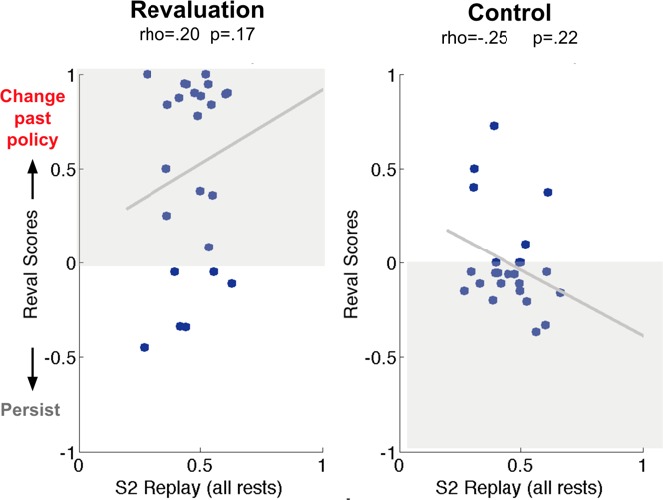
We tested whether Stage two replay was also correlated with subsequent planning (revaluation) behavior.We found no significant correlation. The Figure shows the correlation between replay of Stage two category during rest and subsequent revaluation scores, which is non-significant for both conditions (revaluation: rho = 0.2, p = 0.17; control: rho = -0.25, p = 0.22). Multiple regression did not reveal any significant effect of Stage two replay (ß = 0.84, p = 0.44) but only a significant effect of the Stage one replay on the revaluation scores (ß = 1.89, p = 0.04).